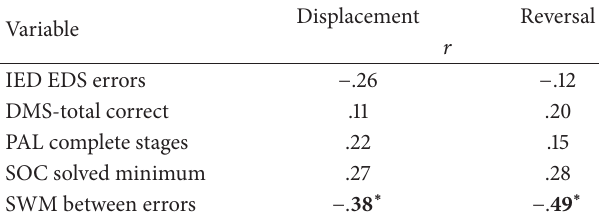
Table 2: Pearson’s correlation 𝑟 values between each CANTAB variableandadaptationmagnitudeforthedisplacementandreversal tasks. Asterisk ( ∗ ) denotes significant correlations at the 0.001 level.